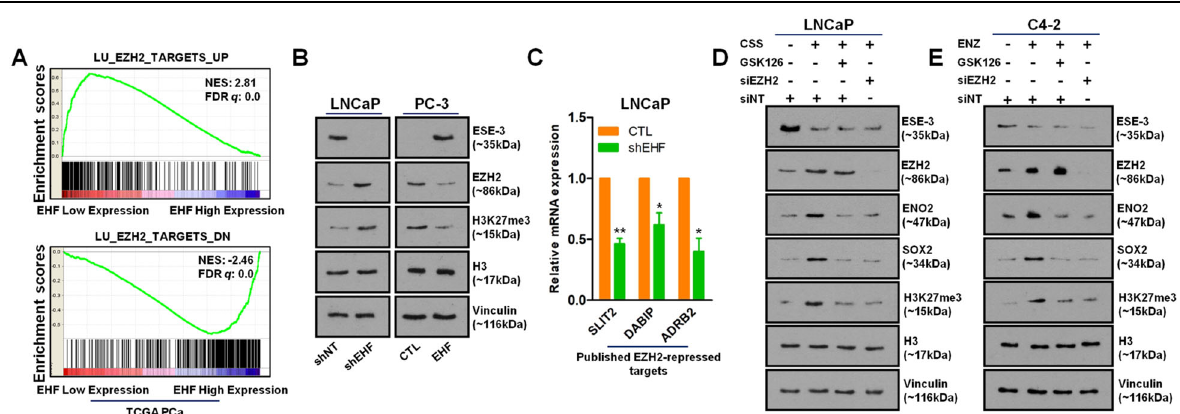
Fig. 4 EZH2 is essential for NE phenotype induced by EHF loss. A GSEA analysis indicated that EZH2 might function as a downstream effector molecule of EHF in prostate cancer. B EHF, EZH2, H3K27me3, and H3 protein expressions in LNCaP cells with/without EHF knockdown and PC-3 cells with/without EHF overexpression were measured by immunoblotting. C The mRNA level of three known EZH2-repressed targets (SLIT2, DABIP, and ADRB2) was measured by qPCR in LNCaP cells with/without EHF knockdown. D EHF, EZH2, ENO2, SOX2, H3K27me3, and H3 protein levels were measured by immunoblotting in CSS cultured LNCaP cells with/without GSK126 treatment (5 μ M) or EZH2 knockdown. E Same tests as in D , except that measured in ENZ-treated (10 μ M) C4-2 cells with/without GSK126 treatment or EZH2 knockdown. The two-tailed Student ’ s t test was used to compare results between two groups with * denoting p < 0.05 and ** denoting p < 0.01. All qPCR and immunoblotting assays were repeated in triplicate. Bar graphs show means ± SD. DN down, H3K27me3 tri-methylation lysine 27 of histone H3, H3 histone